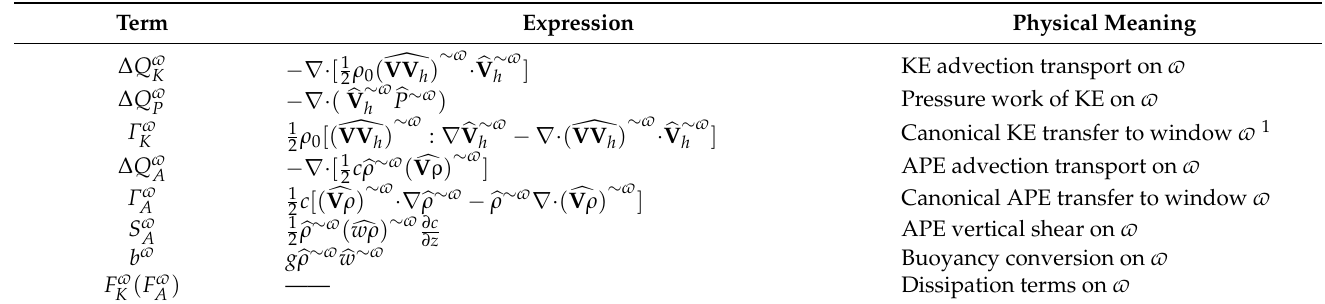
Table 1. Expressions and physical meanings of items on the right in Equations (3) and